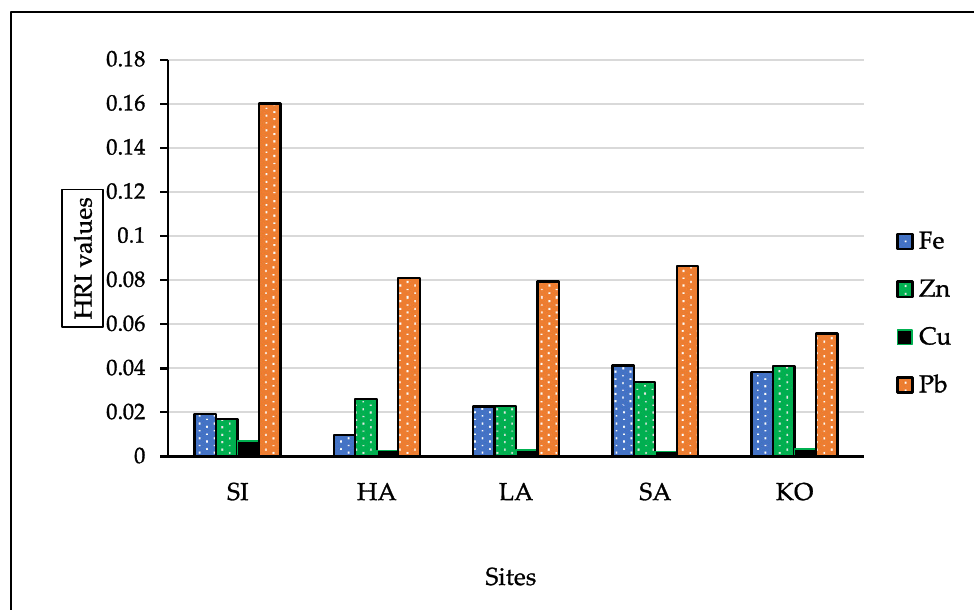
Figure 5. HRI for heavy metals in roof-harvested rainwater.